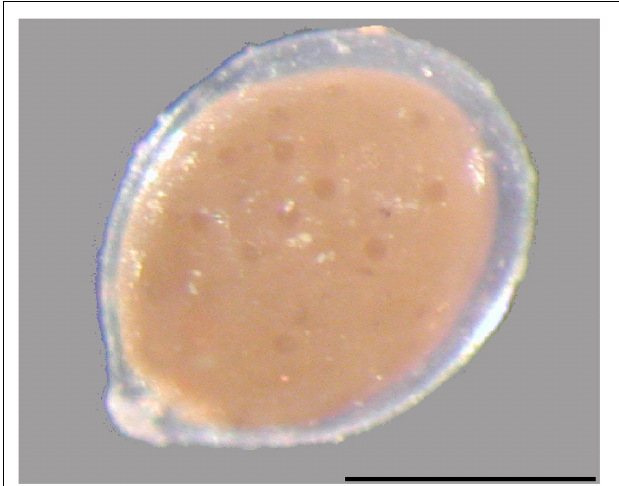
FIGURE 1 | Gromiid cells are surrounded by a proteinaceous test which encloses a cytoplasm filled with stercomata. The oral capsule is seen at the lower left. Scale bar 500 µ